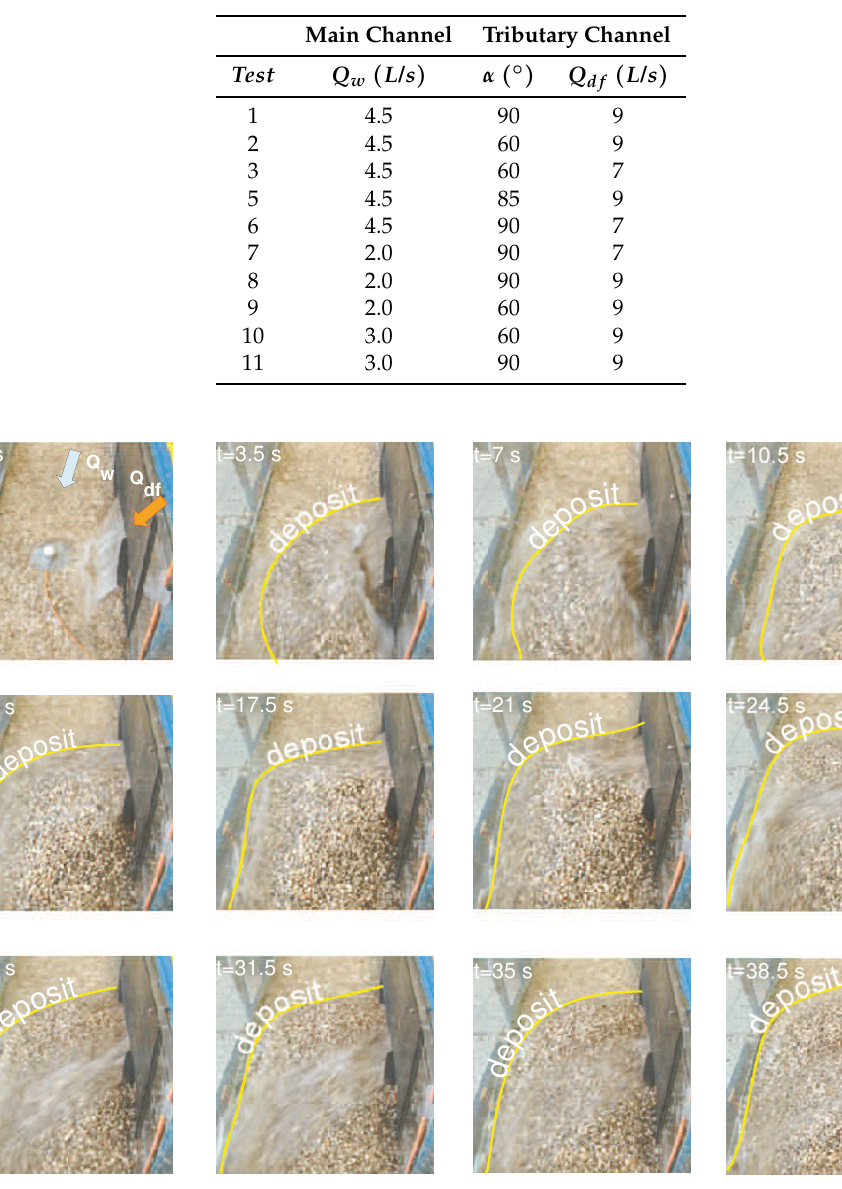
Table 2. Summary of the relevant parameters characterizing the present flume tests. The various quantities are defined as follows: Q w , water discharge along the main channel; α , confluence angle between the tributary and the main channel; Q df , debris flow discharge delivered in the main channel by the tributary channel.